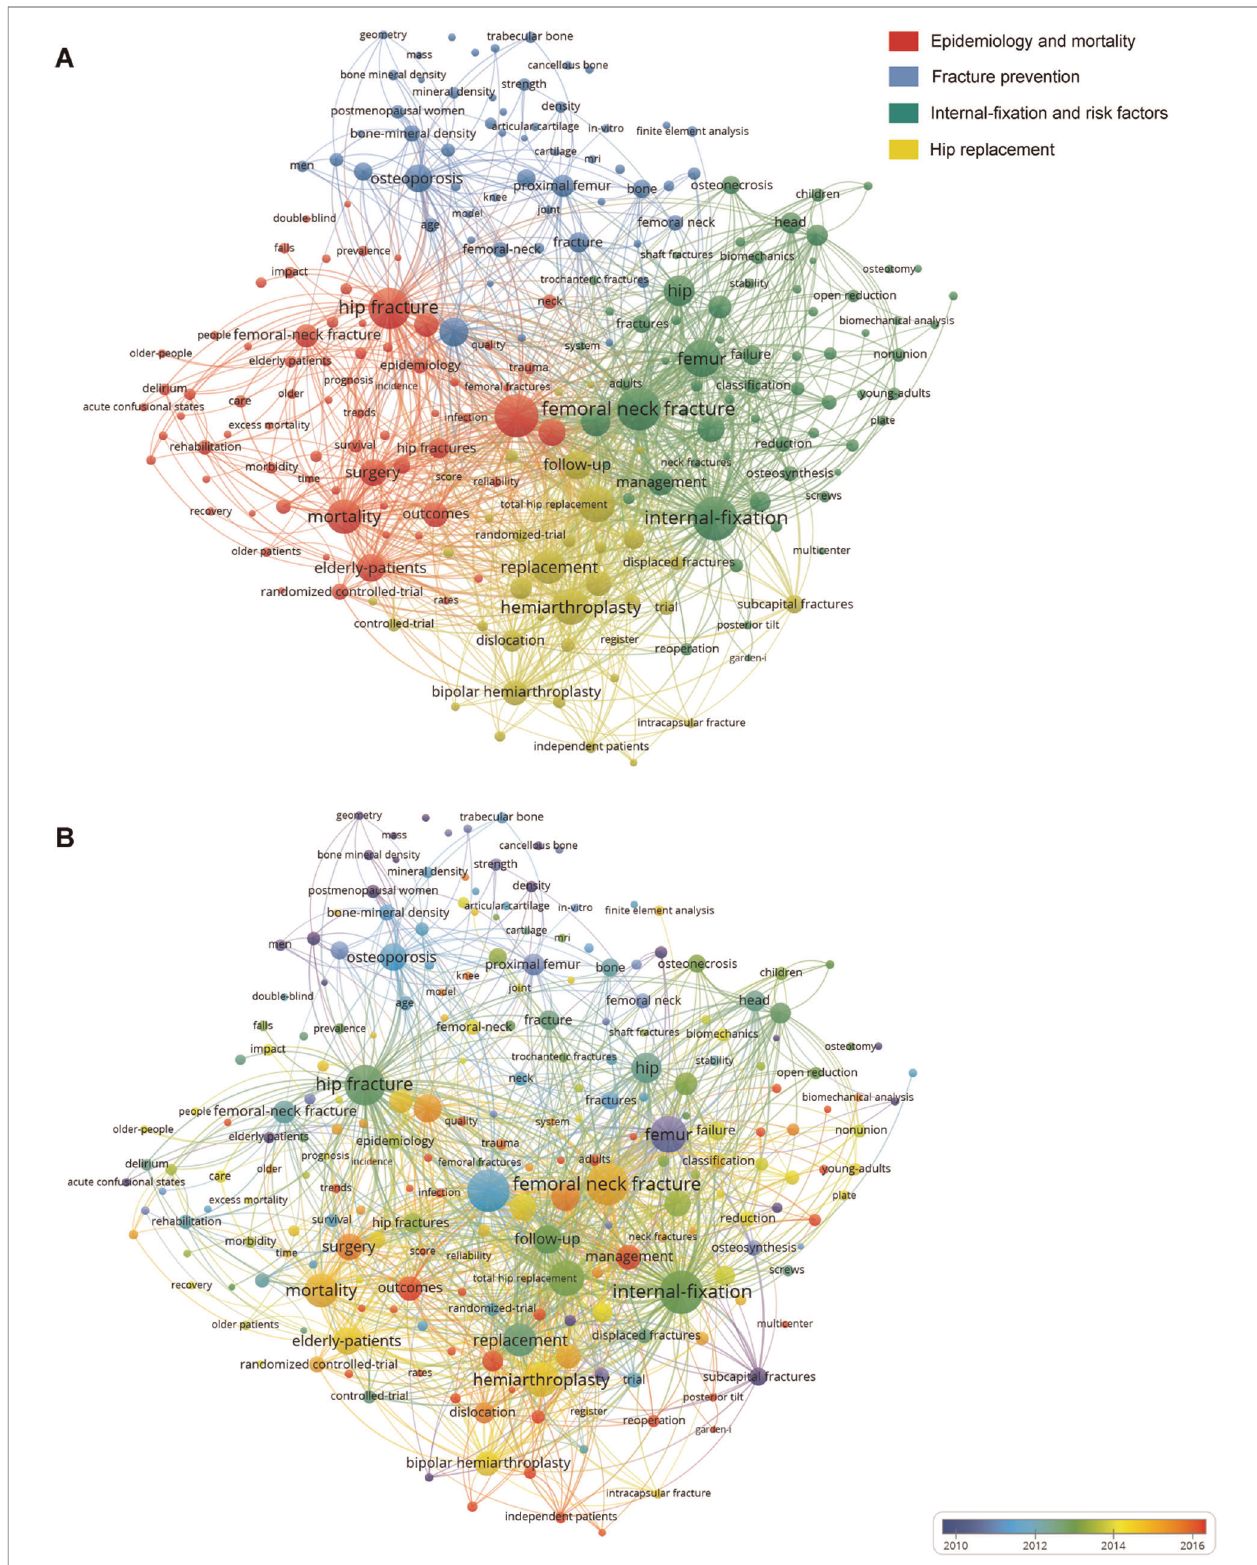
FIGURE 7 | ( A ) Network visualization map of co-occurring keywords related to FNF research created by VOSviewer. ( B ) The overlay visualization map of the keyword co-occurrence analysis using VOSviewer.